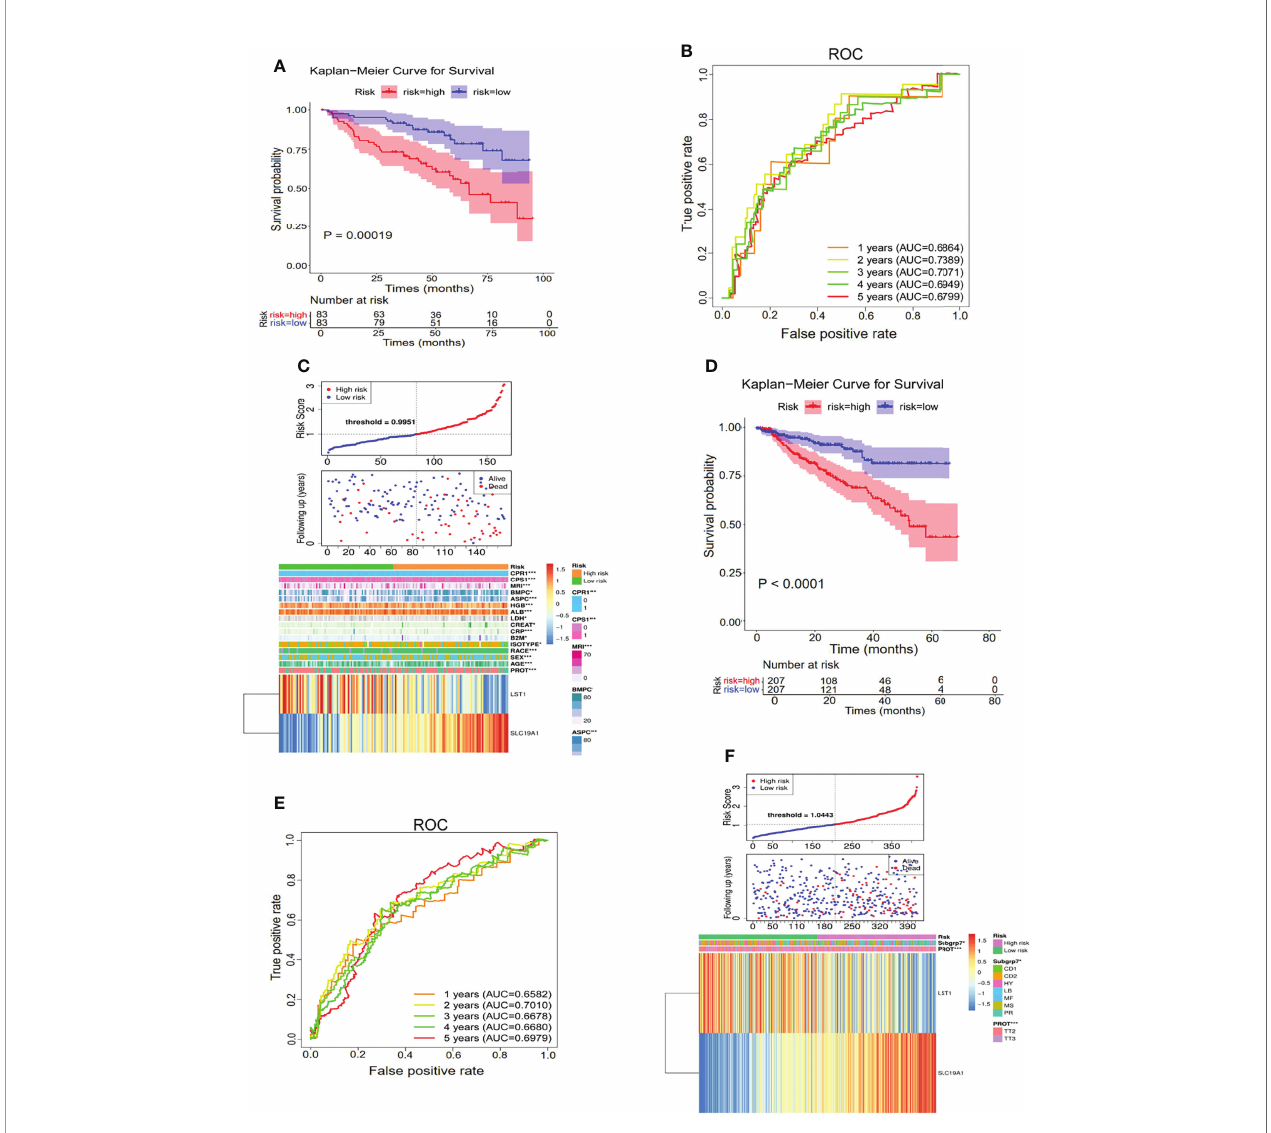
FIGURE 6 | Genetic overexpression of SLC19A1 is correlated with poor prognosis in MM. (A , D) Kaplan – Meier analysis of the risk score model based on SLC19A1 and LST1 to predict patient survival in the internal testing set (A) and GSE4581 dataset (D) . (B , E) Time-dependent ROC curves for the two-gene model to predict patient survival in the internal testing set (B) and GSE4581 dataset (E) . (C , F) The risk score distribution and the survival status of the high- and low-risk groups in the internal testing set (C) and GSE4581 dataset (F)